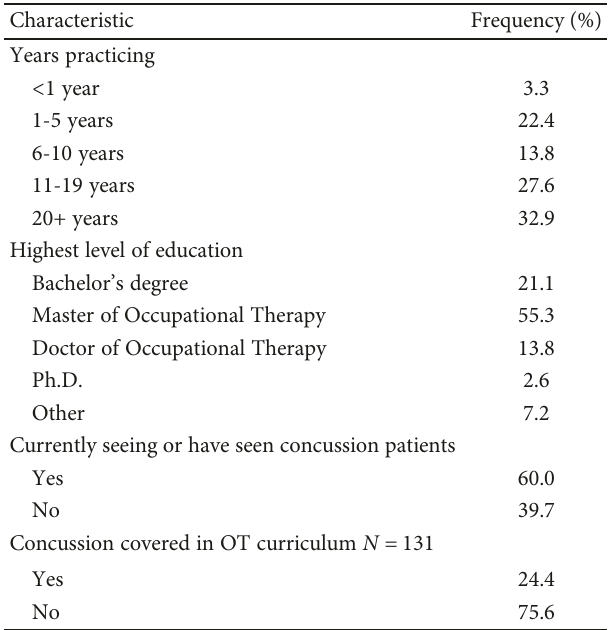
Table 1: Therapist characteristics: clinical experience and education ( N = 153